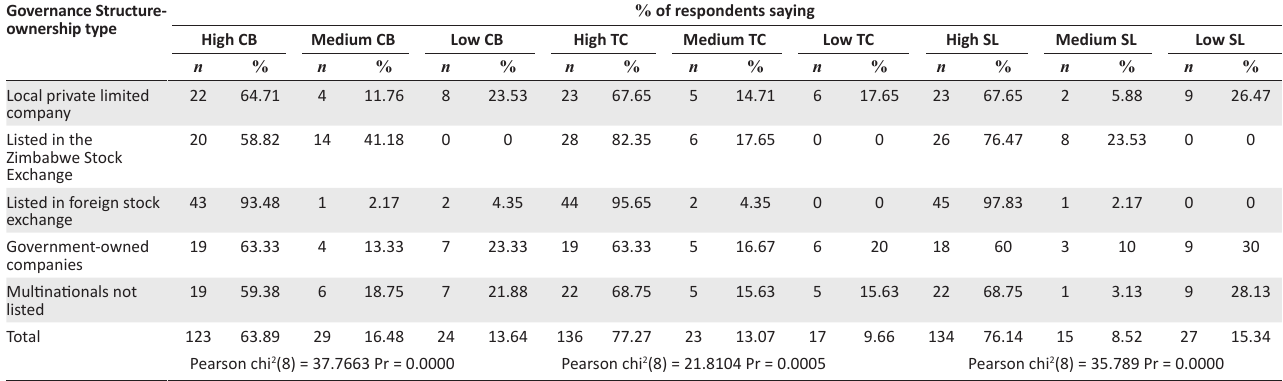
TABLE 2: Employee perceptions on security level, training capacity and collective bargaining. Governance Structure- ownership